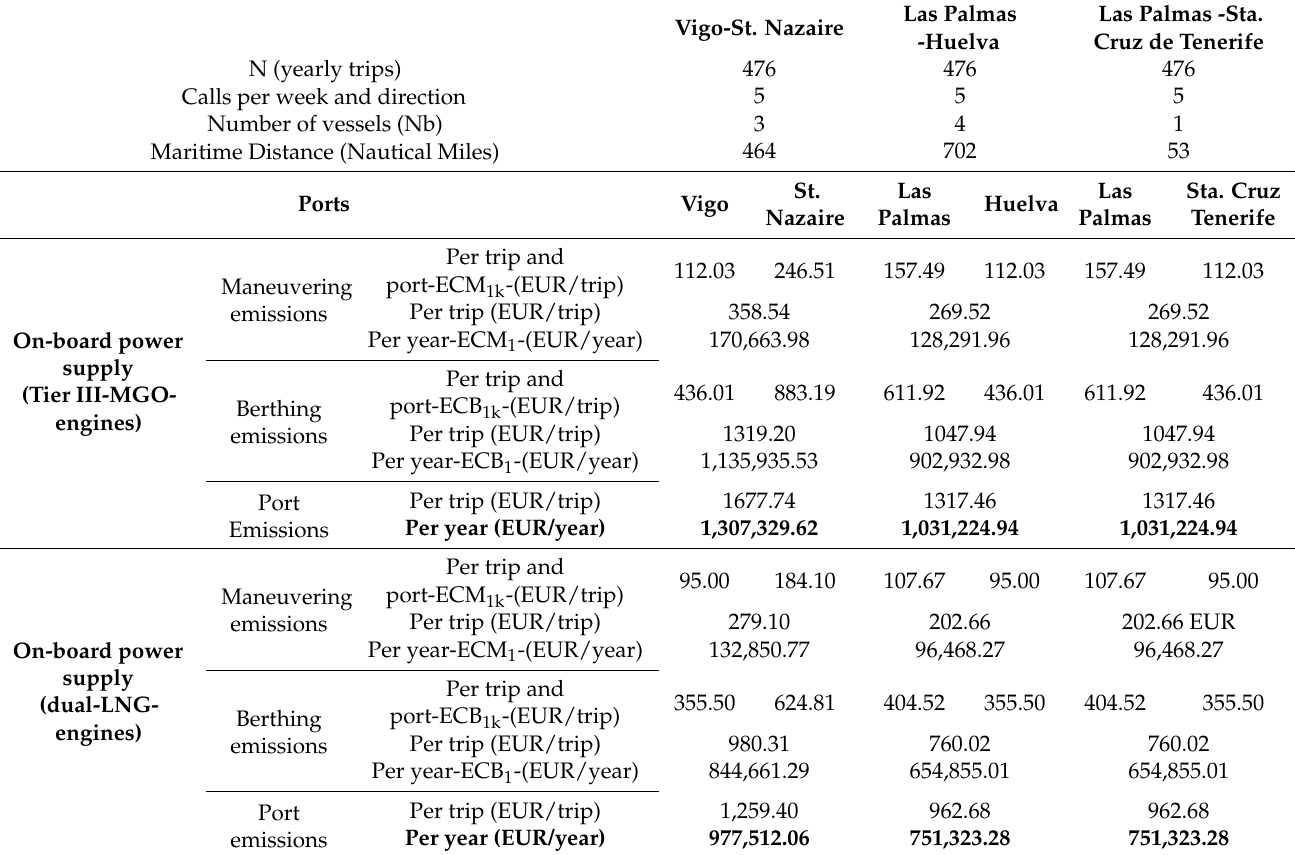
Table 6. Emissions reduction in feeder vessels by port mitigation alternatives